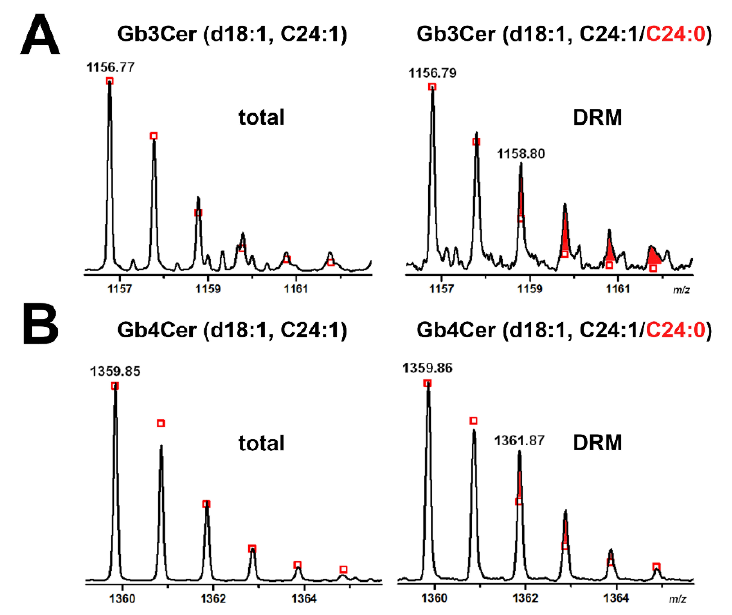
Figure 8. Expanded molecular ion region of Gb3Cer C24 species detected in the total GSL preparation and the GSL sample of DRM fraction F2 ( A ) and the Gb4Cer counterparts ( B ) of serum-free cultivated pHCoEpiCs. The calculated isotope distribution of Gb3Cer and Gb4Cer with Cer (d18:1, C24:1) of the total GSL preparation (left side of panels A and B, respectively) and Gb3Cer and Gb4Cer with Cer (d18:1, C24:1/C24:0) of the GSL sample of DRM fraction F2 (right side of panels A and B, respectively) is marked with open red squares. The red coloured areas at the tips of the signal peaks indicate the additionally occurring Gb3Cer and Gb4Cer lipoforms with Cer (d18:1, C24:0)